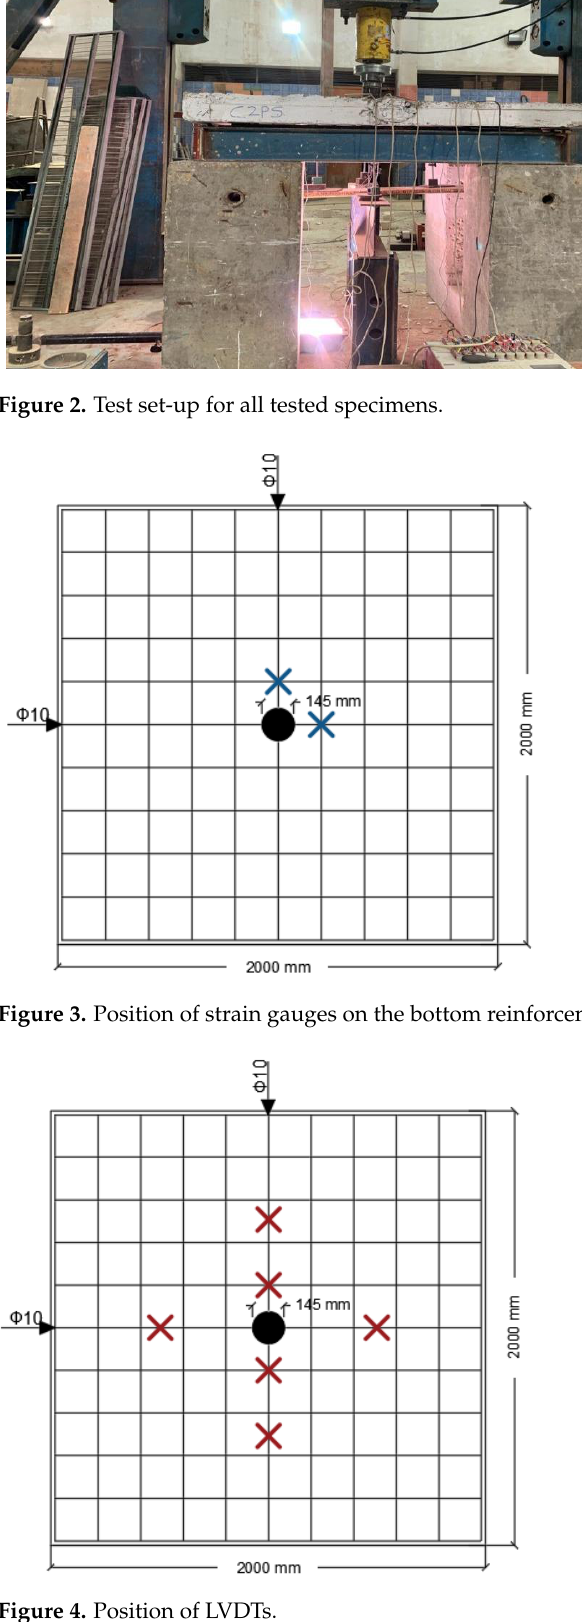
Figure 4. Position of LVDTs.